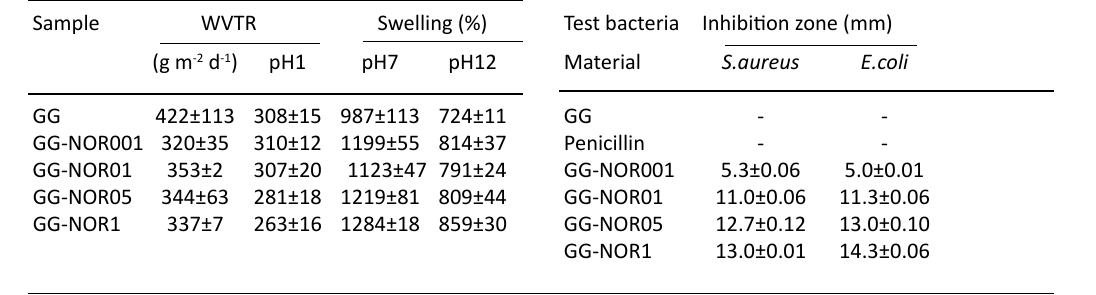
Table 2. Inhibition zone of gellan gum and gellan gum incorporated with norfloxacin against